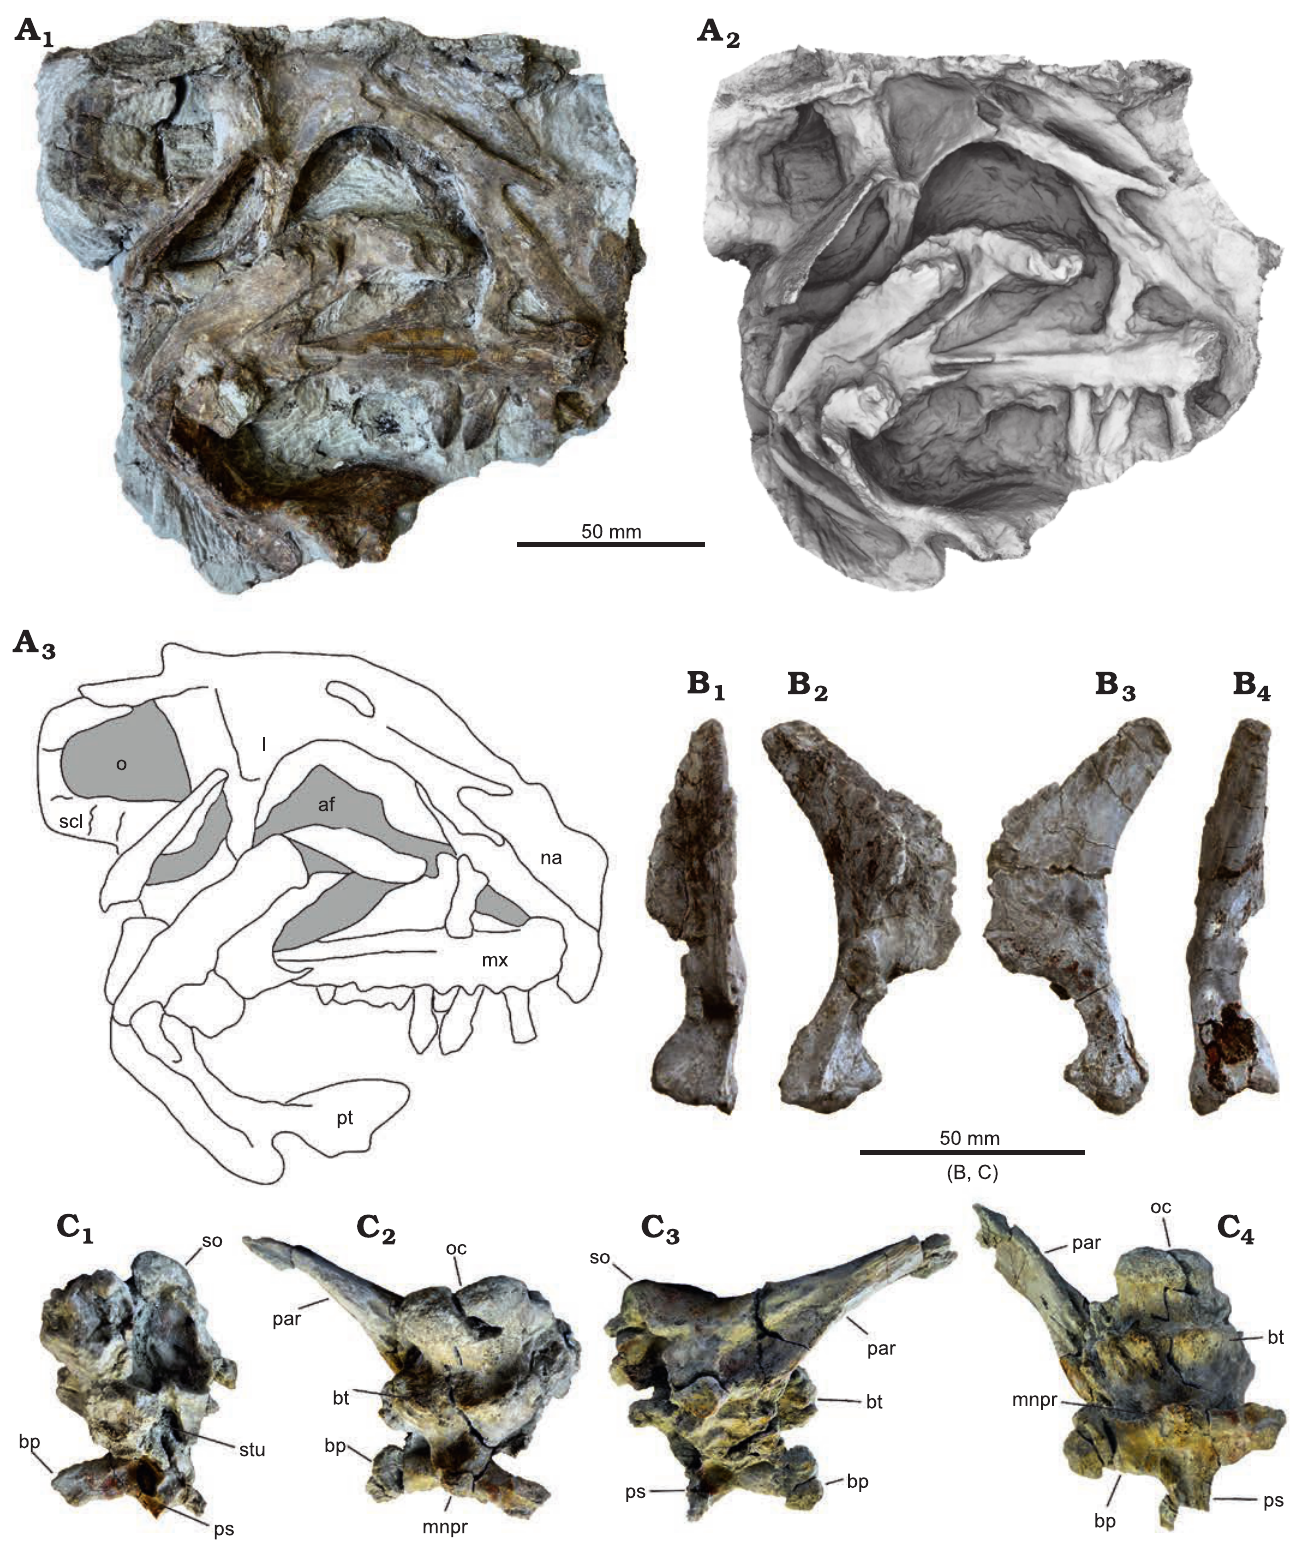
Fig. 13. A . Skull of Plateosaurus trossingensis (MSF 08.M) from the Triassic of Frick, Switzerland. A . Photograph of main block, skull exposed in medial view (A 1 ); ambient occlusion of photogrammetric model of the main block (A 2 ) and interpretational diagram (A 3 ). B . Disarticulated right quadrate in anterior (B 1 ), lateral (B 2 ), medial (B 3 ), and posterior (B 4 ) views. C . Disarticulated braincase in anterolateral (C 1 ), posterior (C 2 ), left lateral (C 3 ), and ven - tral (C 4 ) views. Abbreviations: af, antorbital fenestra; bp, basipterygoid process; bt, basipterygoid tubera; l, lacrimal; mnpr, median process; mx, maxilla; na, nasal; o, orbit; oc, occipital condyle; par, paroccipital process; ps, parasphenoid; pt, pterygoid; scl, sclerotic ring; so, supraoccipital; stu, sella